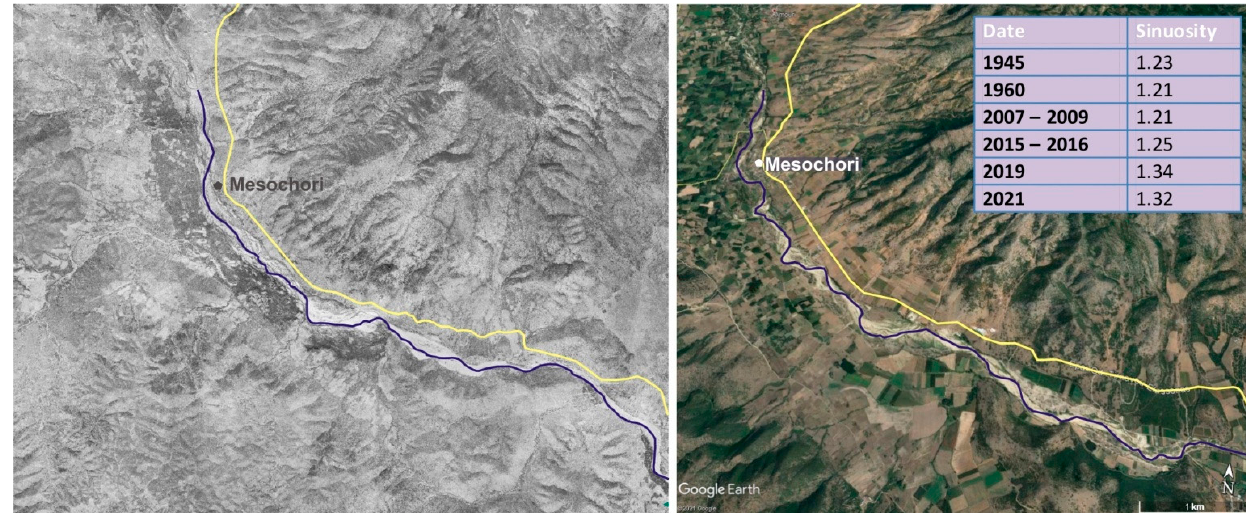
Figure 16. Change in sinuosity ratio of the Titarissios River (blue line) between 1945 and 2021.